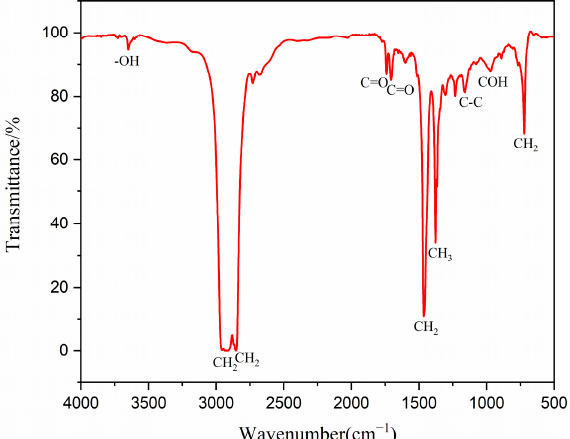
Figure 4. FTIR spectrum of WEO.